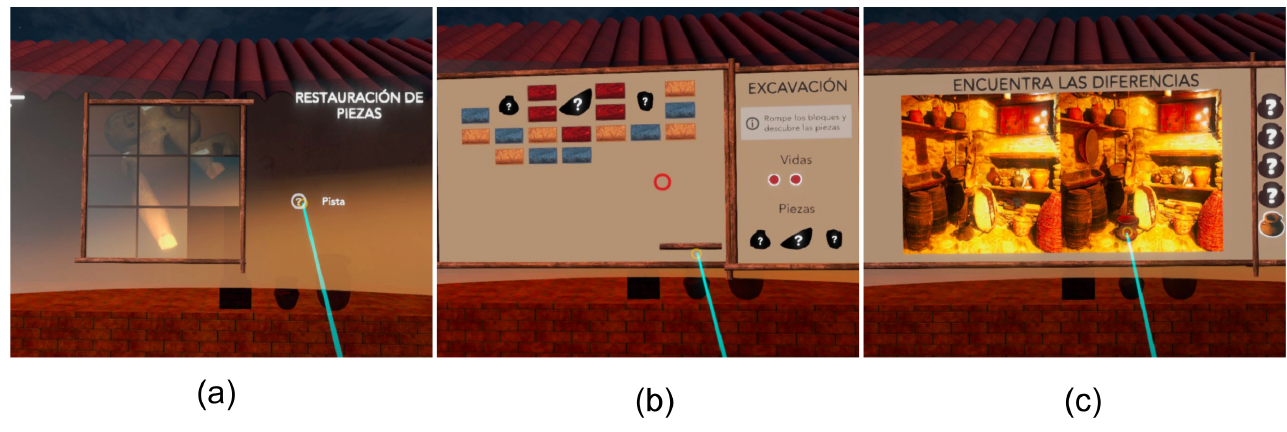
Figure 6. Games developed: ( a ) a 2D sliding puzzle (piece restoration); ( b ) discover the historical 3D piece (excavation); ( c ) find the